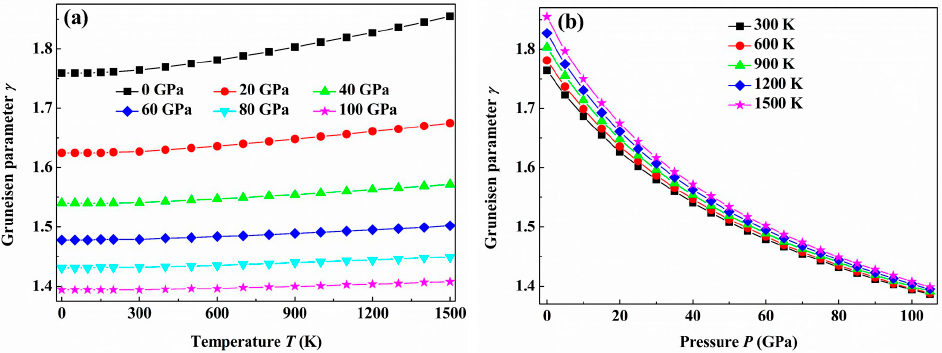
Figure 10. Temperature ( a ) and pressure ( b ) dependence of the thermal expansion coefficient α for the C 2/ m -ZrB 3 . Figure 11. Temperature ( a ) and pressure ( b ) dependence of the Grüneisen parameter γ for the C 2/ m -ZrB 3 .